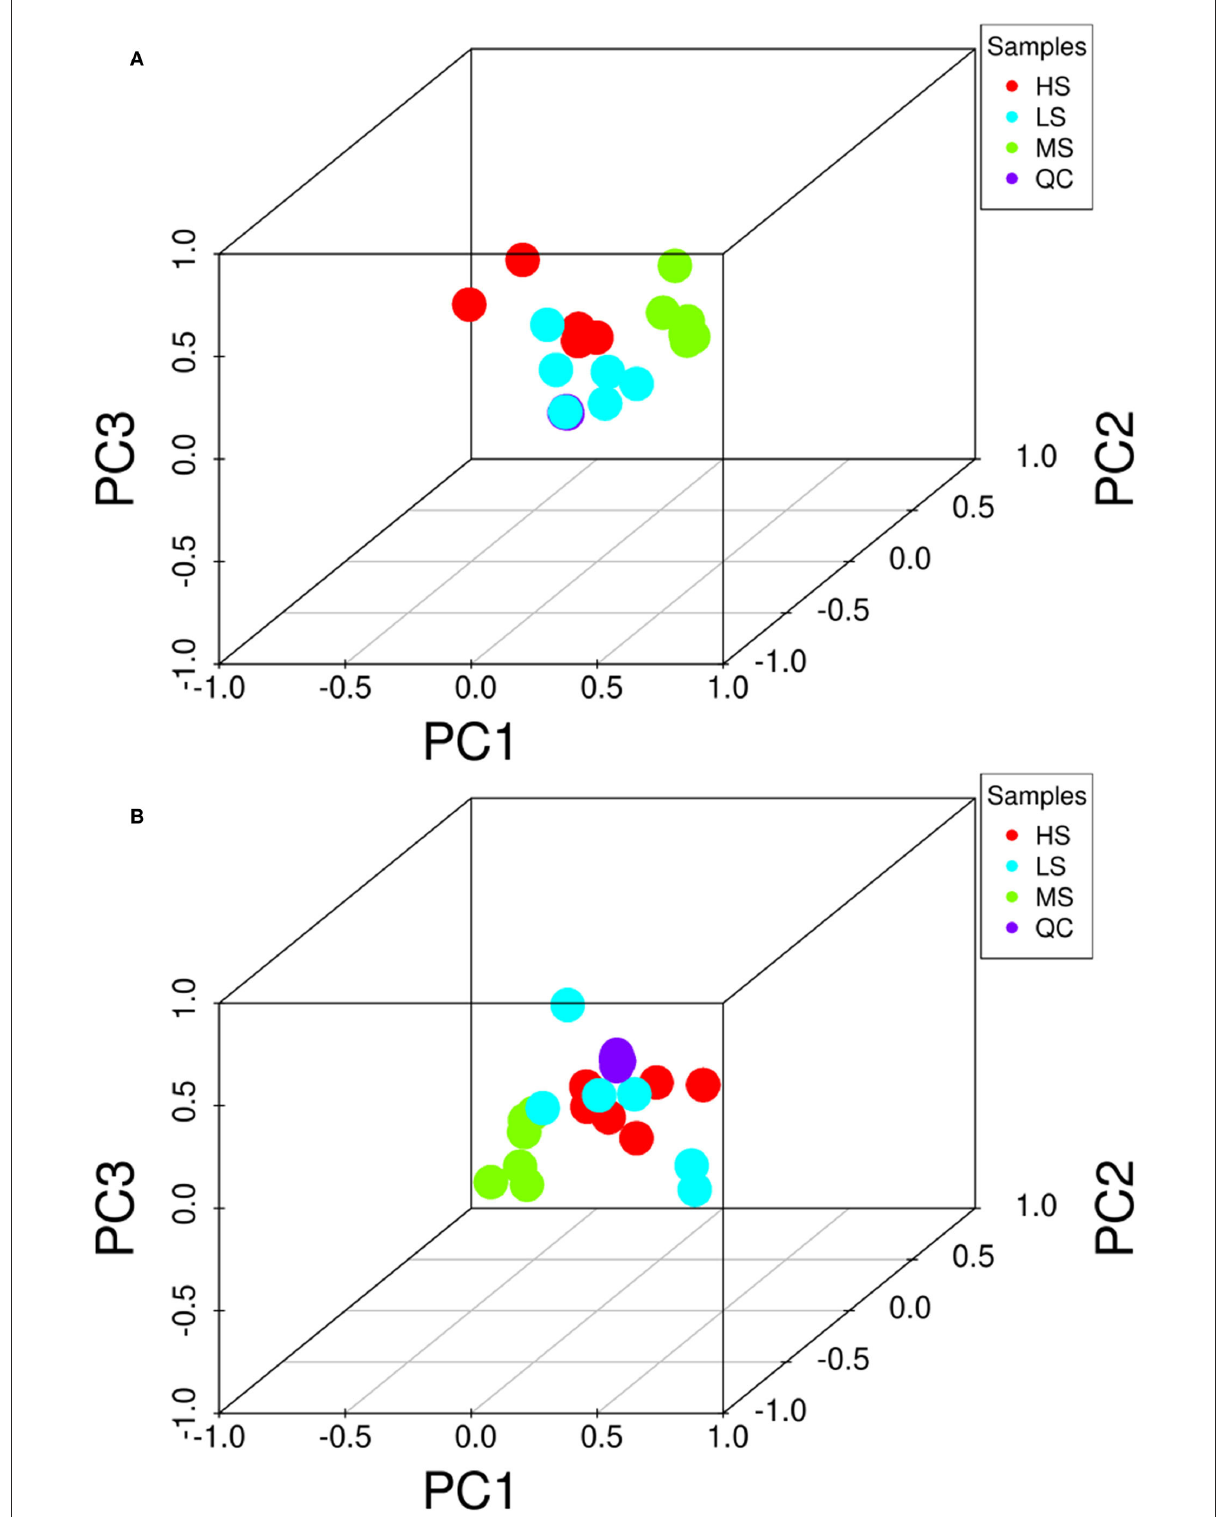
FIGURE2 3D PCA score of the overall samples in the positive (A) and negative (B) ion detection mode. The HS group is marked as red, the MS group is marked as green, the LS group is marked as blue, and the QC samples are indicated with purple. PC1 represents principal component 1, PC2 represents principal component 2, and PC3 represents principal component